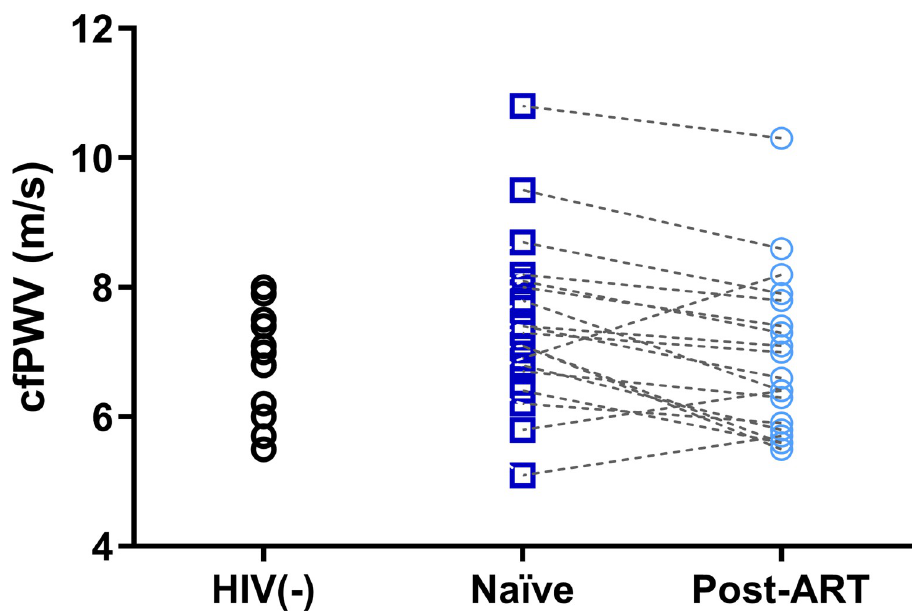
Fig 1. Carotid-femoral pulse wave velocity (cfPWV) in HIV(-), treatment- naïve HIV(+), and after one-year follow-up of antiretroviral therapy (post-ART).